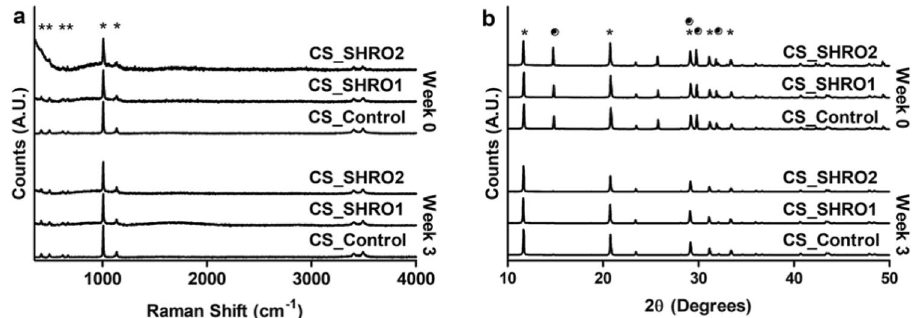
Figure 2. ( a ) Raman spectra and ( b ) XRD powder diffraction patterns for CS_Control, CS_SHRO1 and CS_ SHRO2 cements as prepared (Week 0) and following 3 weeks of static ageing in distilled water (Week 3) . Peaks corresponding to CaSO 4 ·0.5H 2 O are indicated with a (•) and those relating to CaSO 4 ·2H 2 O are shown with a (*) (GraphPad Prism V5.0).